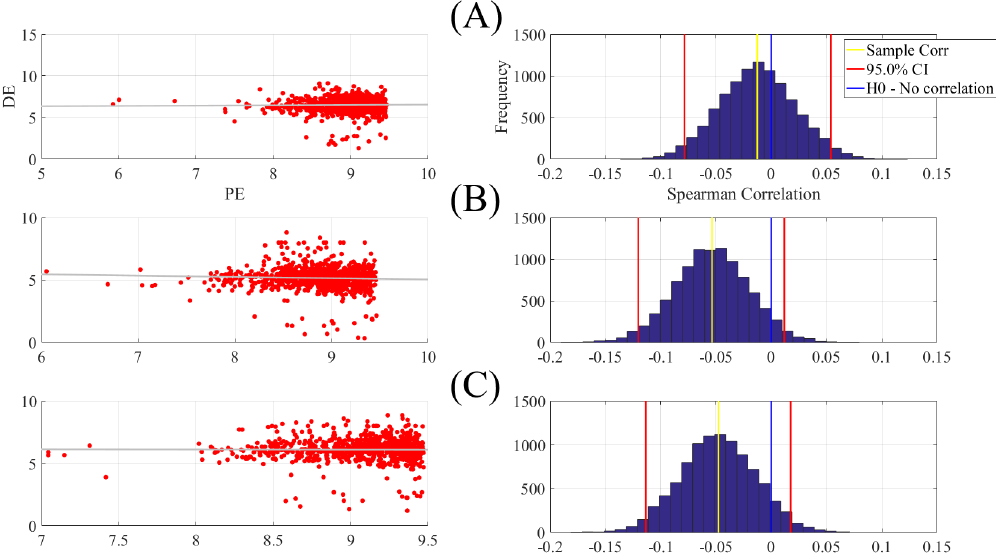
Figure A14. Spearman correlation between participants’ DEs (i.e., 62 DEs associated with 62 EEG channels of a participant, per affect) and their corresponding PE5 values (i.e., 62 PE5s associated with 62 EEG channels of a participant, per affect) in ( A ) Negative ( B ) Neutral ( C ) Positive. The subplots on the right column correspond to the bootstrap correlation test (10,000 simulation runs) at the 95.0% confidence interval. Table A11. Bootstrap (10,000 simulation runs) 95.0% confidence intervals (CI) associated with the Spearman correlation between PE5s (i.e., 62 PE5s associated with 62 EEG channels of a participant, per affect) and DEs (i.e., 62 DEs associated with 62 EEG channels of a participant, per affect) in the negative, neutral, and positive mental states.